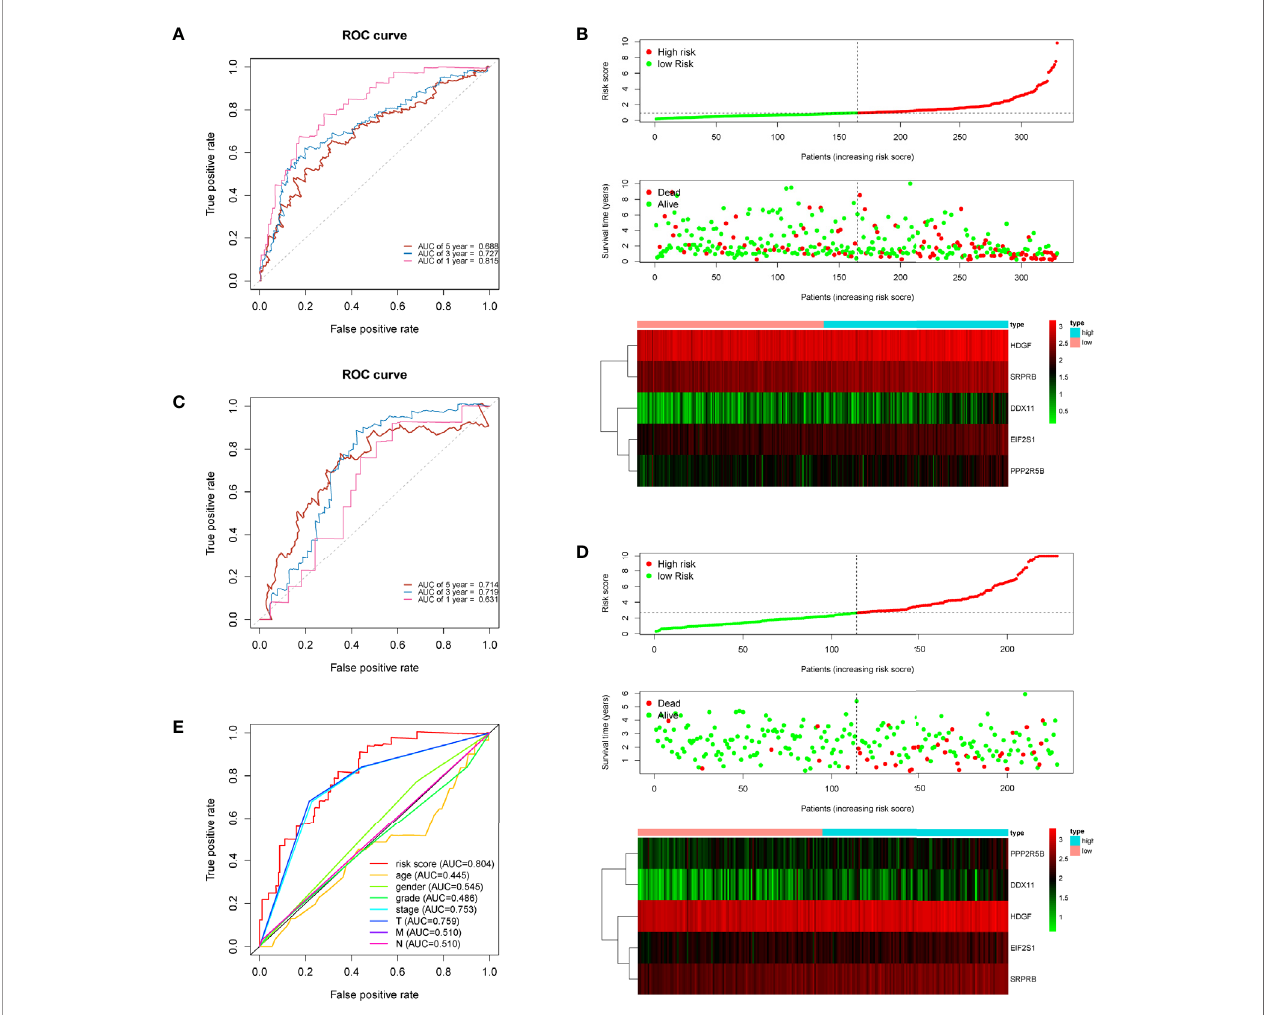
FIGURE 2 | Time-dependent ROC analysis and risk scoring analysis were used for the 5-gene signature in HCC. Time-related ROC analysis (A) , and risk score (B) in the training set of TCGA cohort. Time-related ROC analysis (C) , and risk score (D) in the testing set of ICGC cohort. multi-index ROC analysis in the TCGA cohort (E)